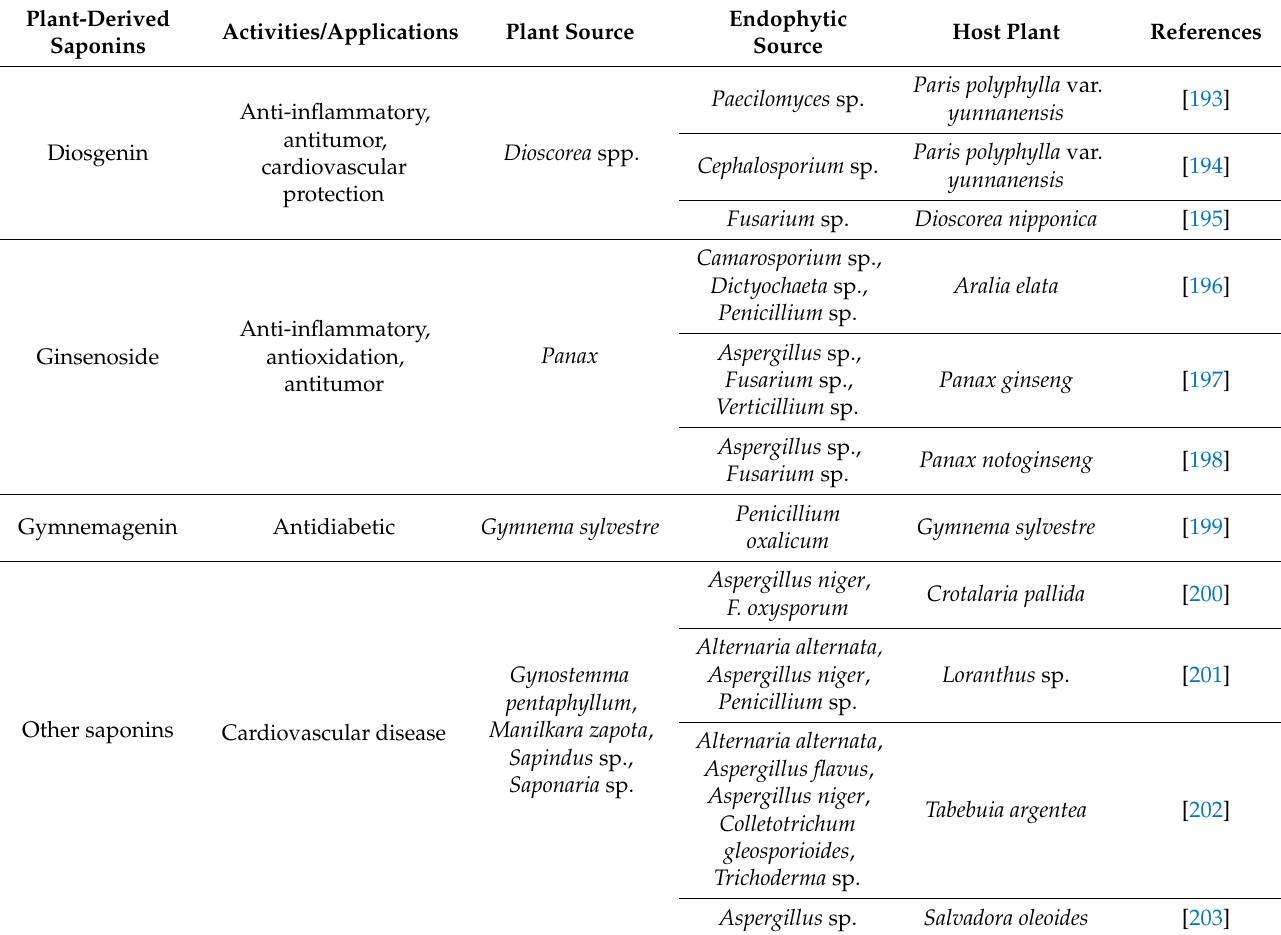
Table 5. Plant-derived saponins produced by endophytic